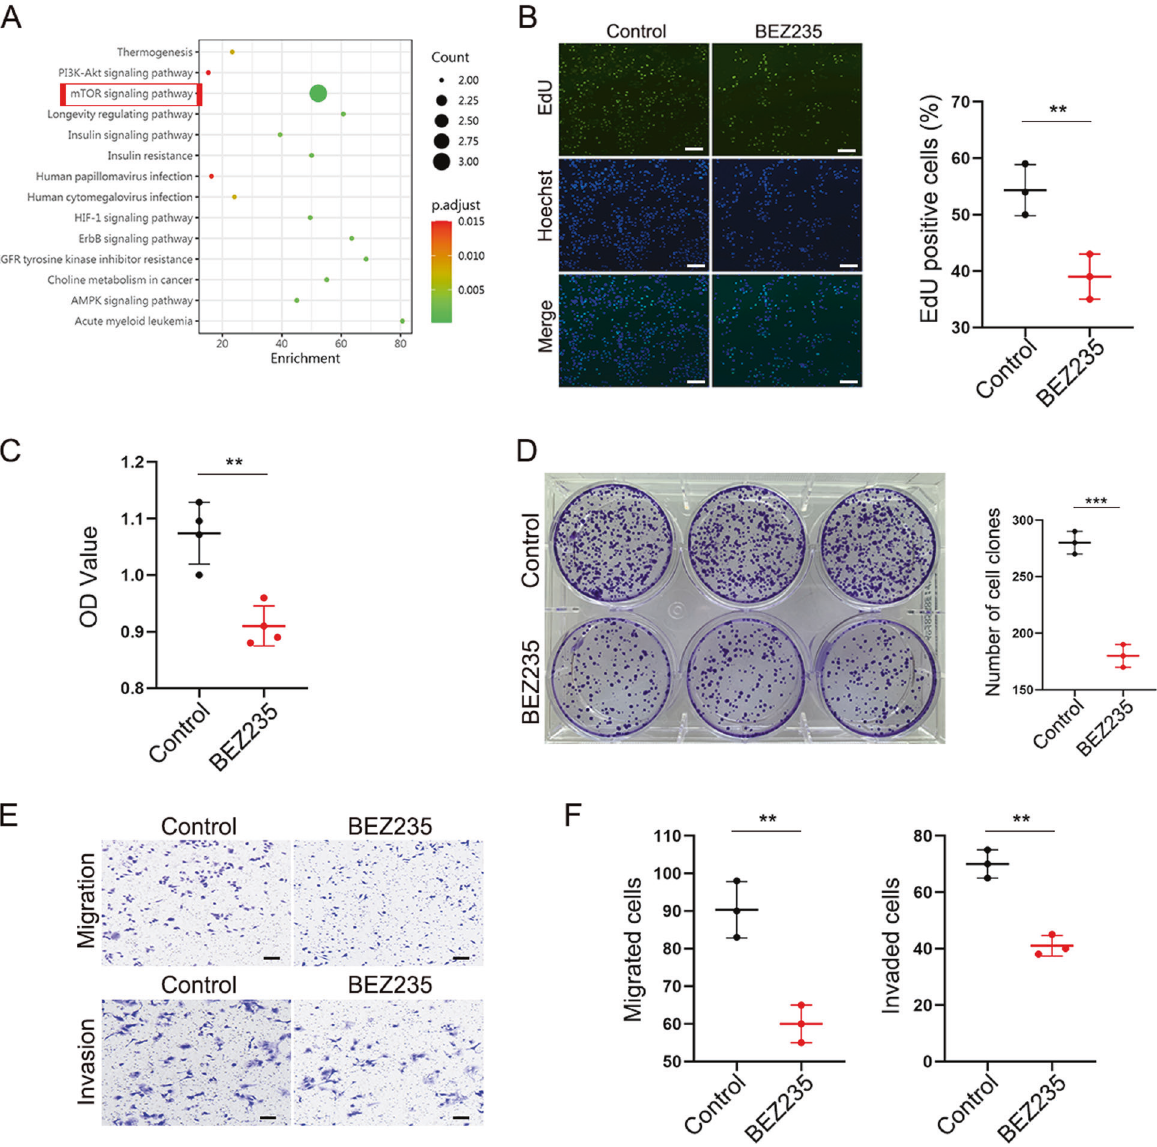
Fig. 1 The PI3K/mTOR dual inhibitor inhibits the function of ICC cells in vitro. A KEGG pathway analysis showing the activated/ phosphorylated protein between human intrahepatic biliary epithelial cell line (HIBEpiC) and human cholangiocarcinoma cell line (RBE). B EdU assay, C Cell Counting Kit-8 assay and D colony formation assay showing the cell proliferation ability in RBE cells treated with DMSO or BEZ235 (100 nM) for 24 h. Magni fi cation, ×100; scale bar, 100 μ m. E , F Transwell assay showing the migration potential and invasion potential of BEZ235 and DMSO treatment. Magni fi cation, ×100; scale bar, 100 μ m. The data are shown as the mean ± SEM (* p < 0.05, ** p < 0.01, *** p <